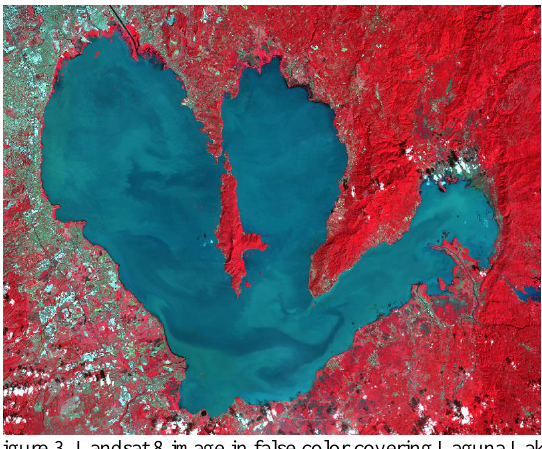
Figure 3. Landsat 8 image in false color covering Laguna Lake